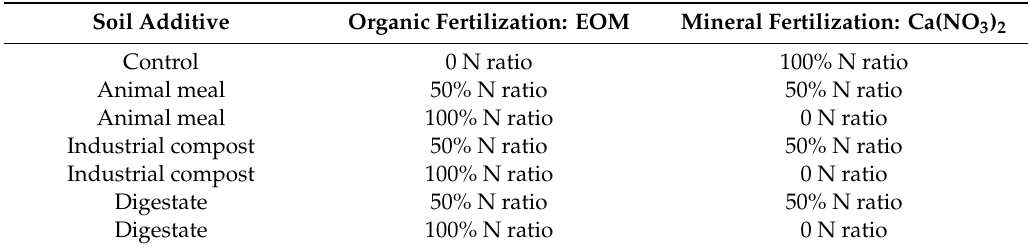
Table 3. Characteristics of combinations of soil additives used in the